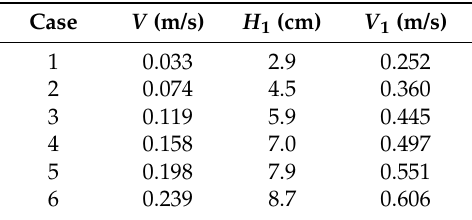
Table 1. Six different cases for model test.